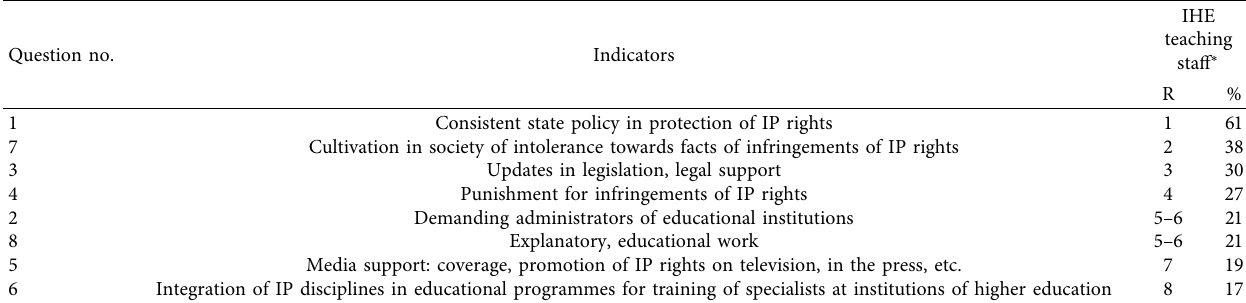
Table 10: Factors enhancing IPR protection.